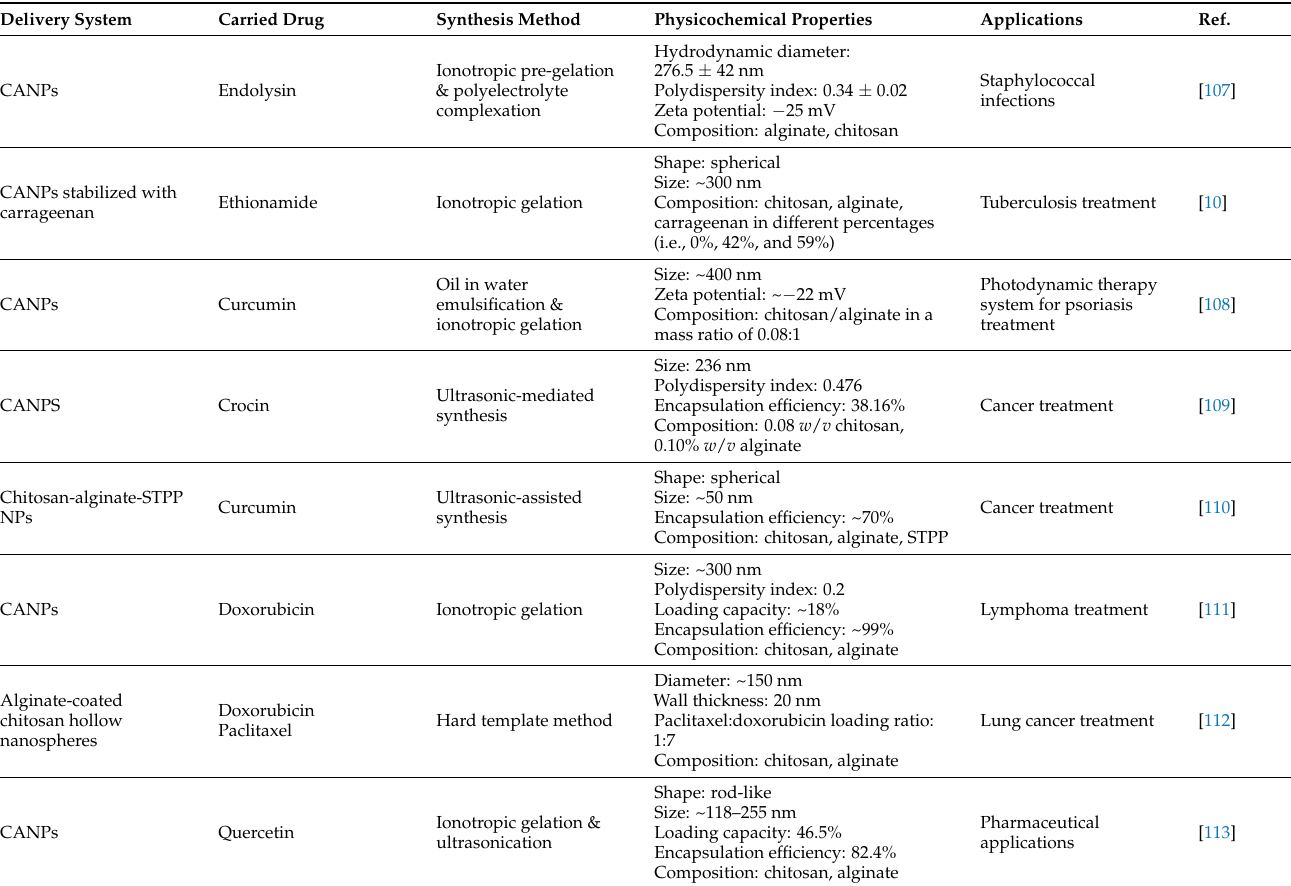
Table 4. Examples of in vitro-tested drug delivery systems based on chitosan-alginate